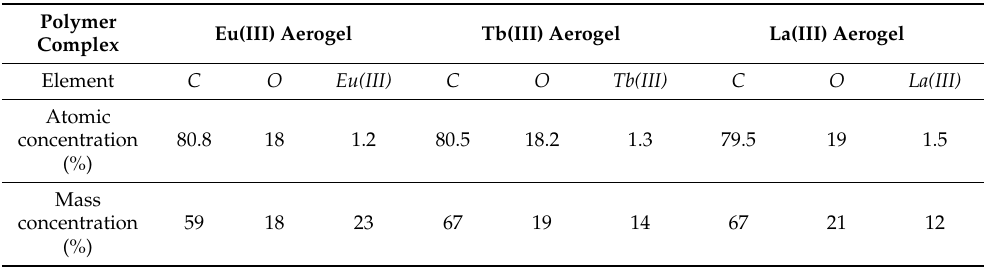
Table 1. C, O, Eu(III), Tb(III), and La(III) concentrations recorded for the prepared